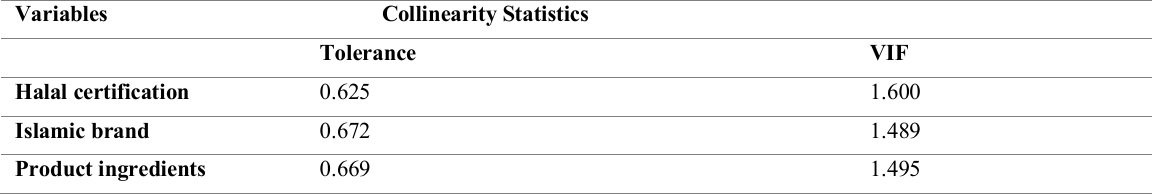
Table 6: Collinearity statistics of Thailand